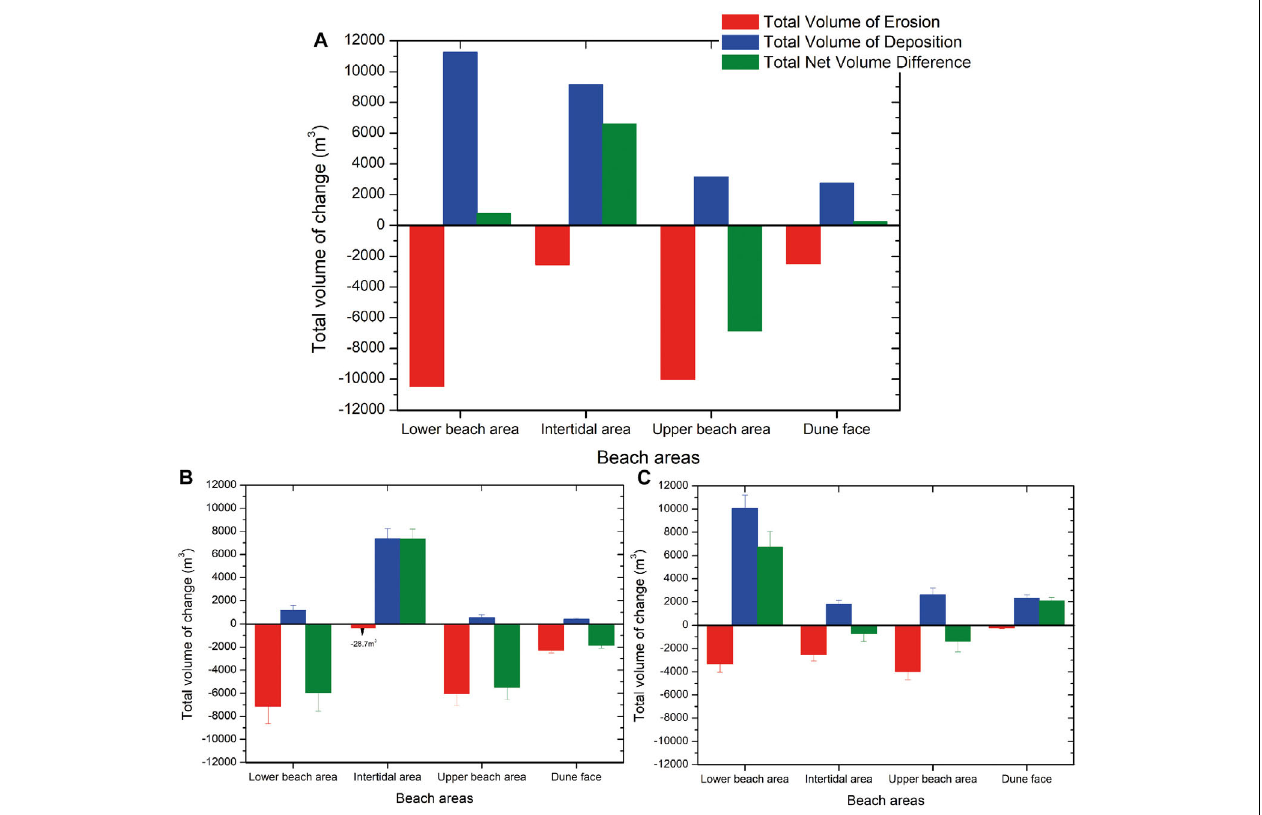
FIGURE 9 | Total volumetric changes (m 3 ) detected from DoD analysis corresponding to the combined effect of both main storms (A) . The bars show the budget segregation at defined beach areas for comparative purposes. Graphs (B,C) represent the volumetric changes induced by Storm Ophelia (from Guisado-Pintado and Jackson, 2018) and (C) Storm Hector respectively with errors